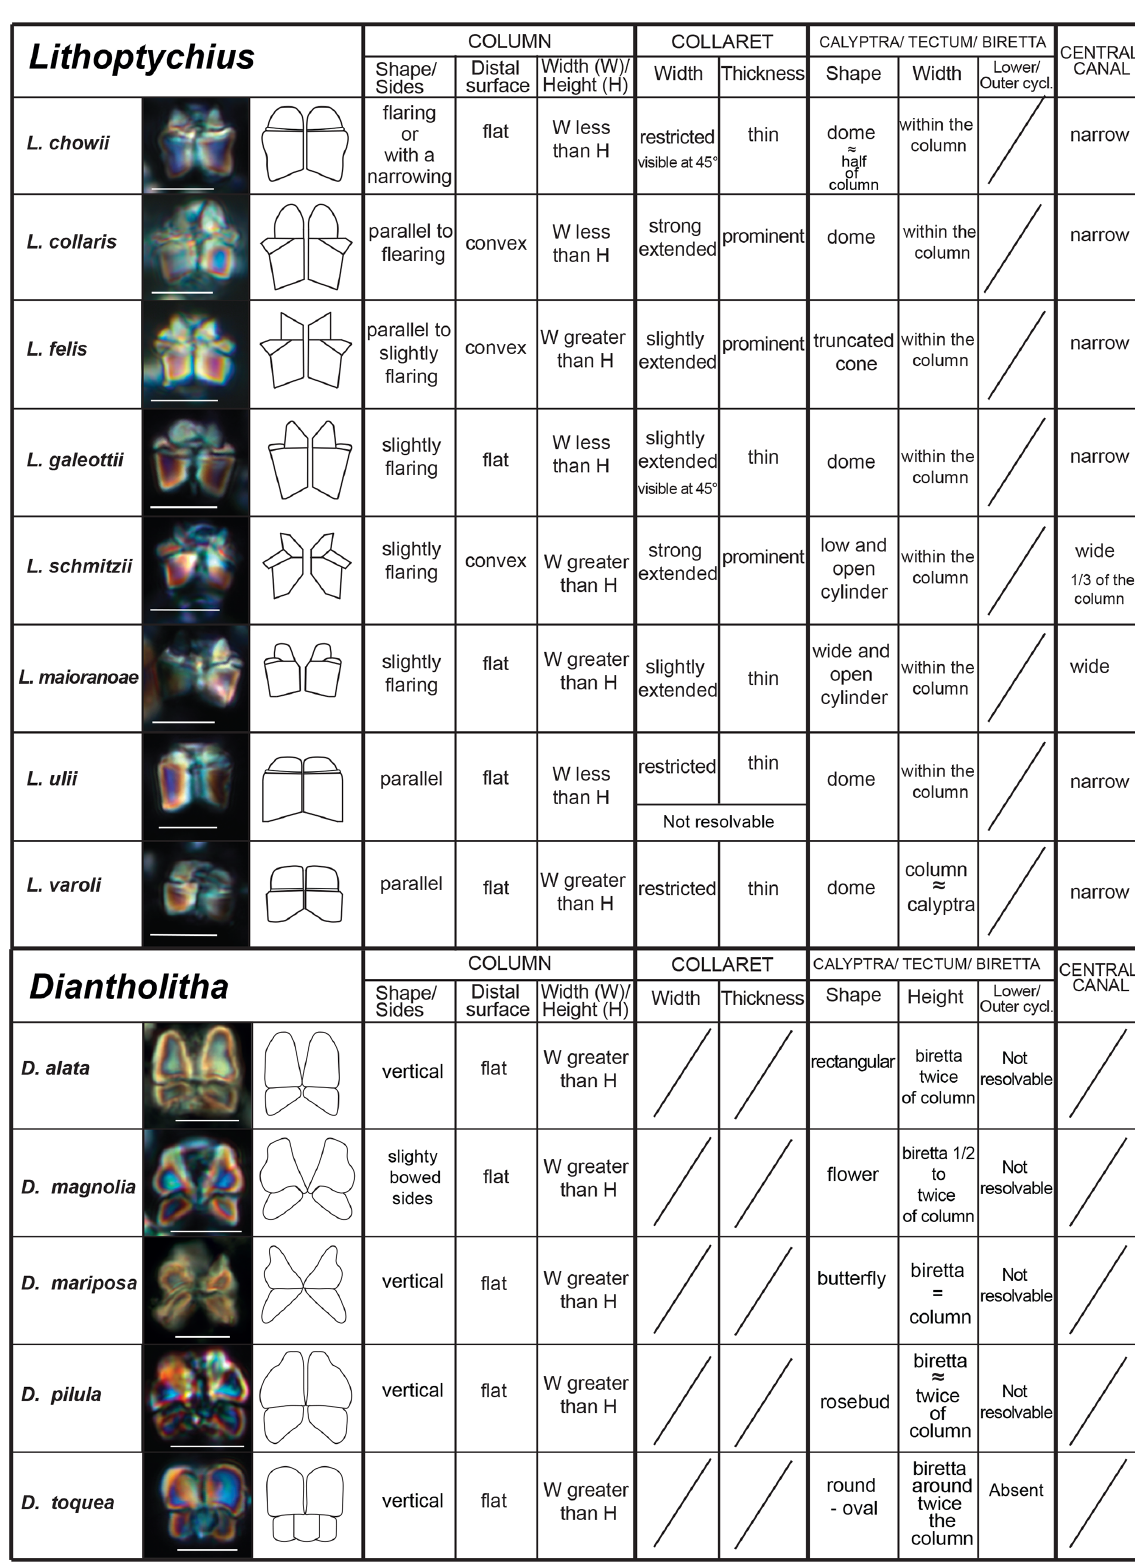
Figure 5. Scheme of the main characteristics to identify of Lithoptychius and Diantholitha . Scale bar 5µm.